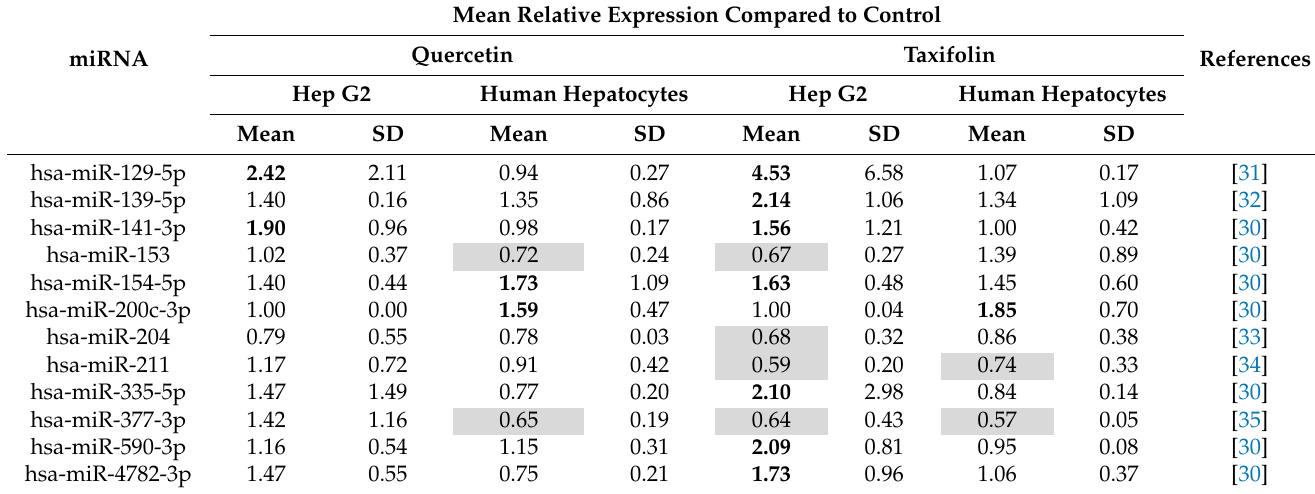
Table 1. Expression analysis of miRNAs that contain ZEB2 as their validated target in Hep G2 and human hepatocytes. Mean Relative Expression Compared to miRNA